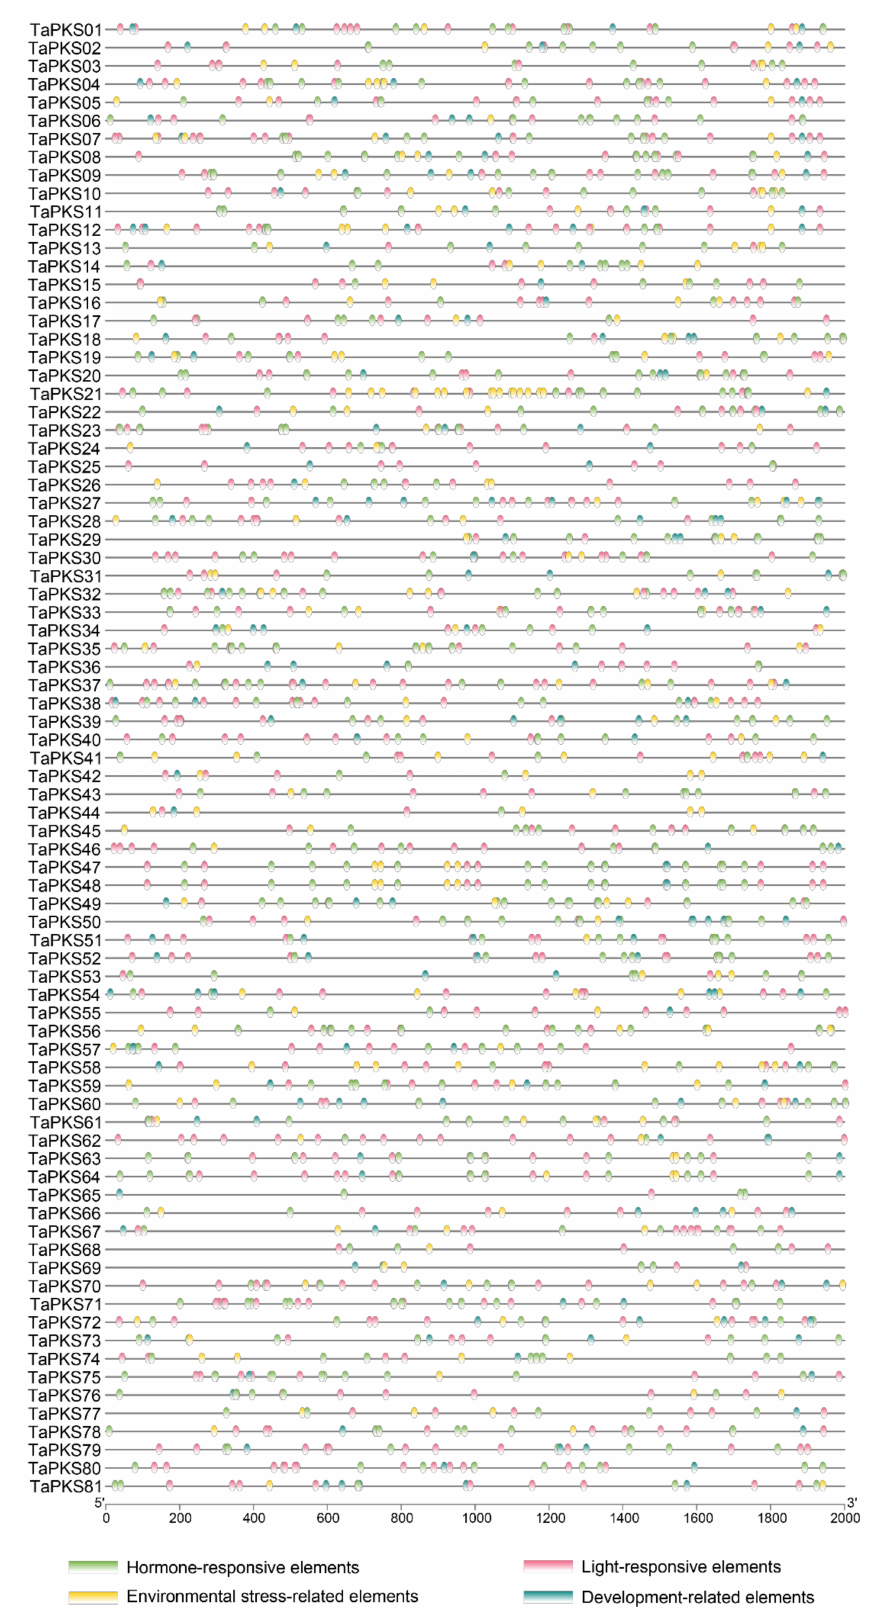
Figure 7. Predicted cis-acting elements in promoters of PKS genes in wheat. The ellipses with different colors represent different promoter elements and the scale at the bottom shows the length of the